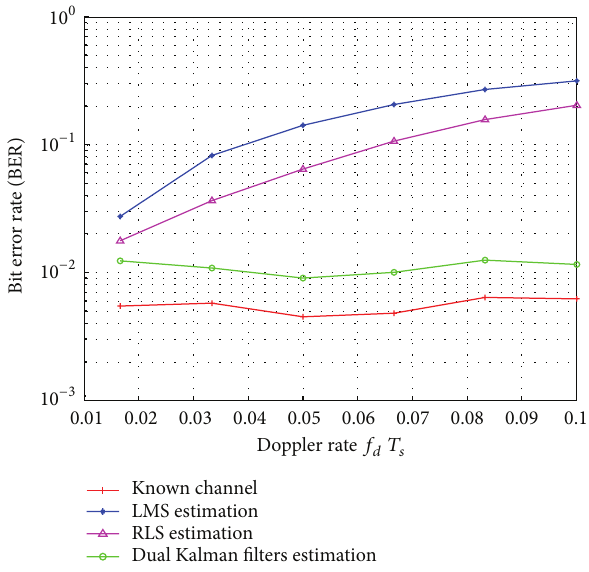
Figure 7: BER performance versus Doppler rate for the FBMC/OQAM system with the various channel estimators. SNR = 15dB, 𝑀 = 2048 , and 𝑁 𝑝 = 1024